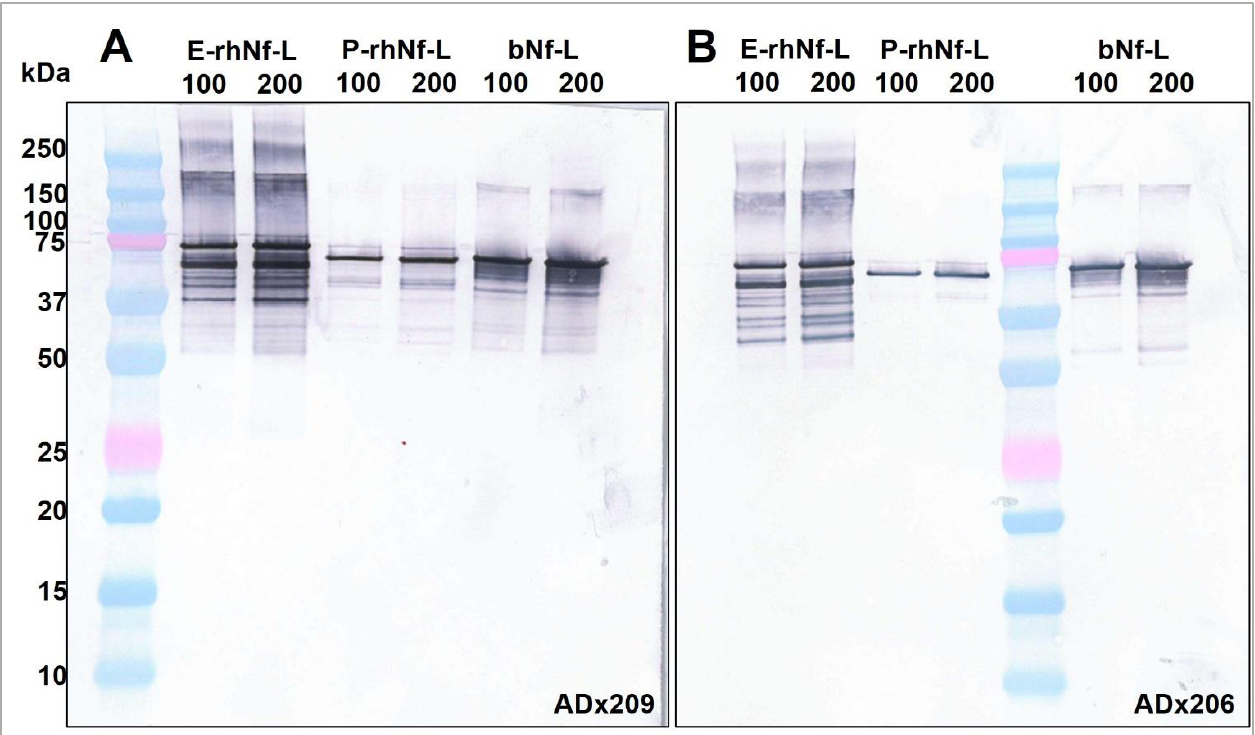
Figure 8. Western blot showing the reactivity of ( A ) ADx209 and ( B ) ADx206 antibodies to primary calibrators bNf-L (MyBioSource), E-rhNf-L (EnCor), and P-rhNf-L (Promise). For each calibrator, two lanes were loaded on the gel with 100 ng and 200 ng of protein, as indicated on the blot. Unloaded lanes have been cropped from the blots.